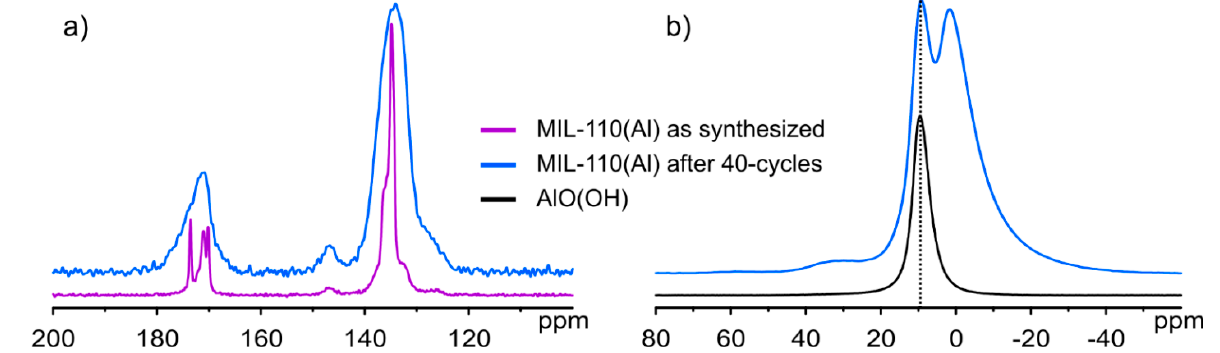
Figure 6. ( a ) 1 H- 13 C CPMAS NMR spectra of MIL-110(Al) before and after cycling test; ( b ) 27 Al single pulse NMR spectra of AlO(OH) and MIL-110(Al) after 40-cycles.